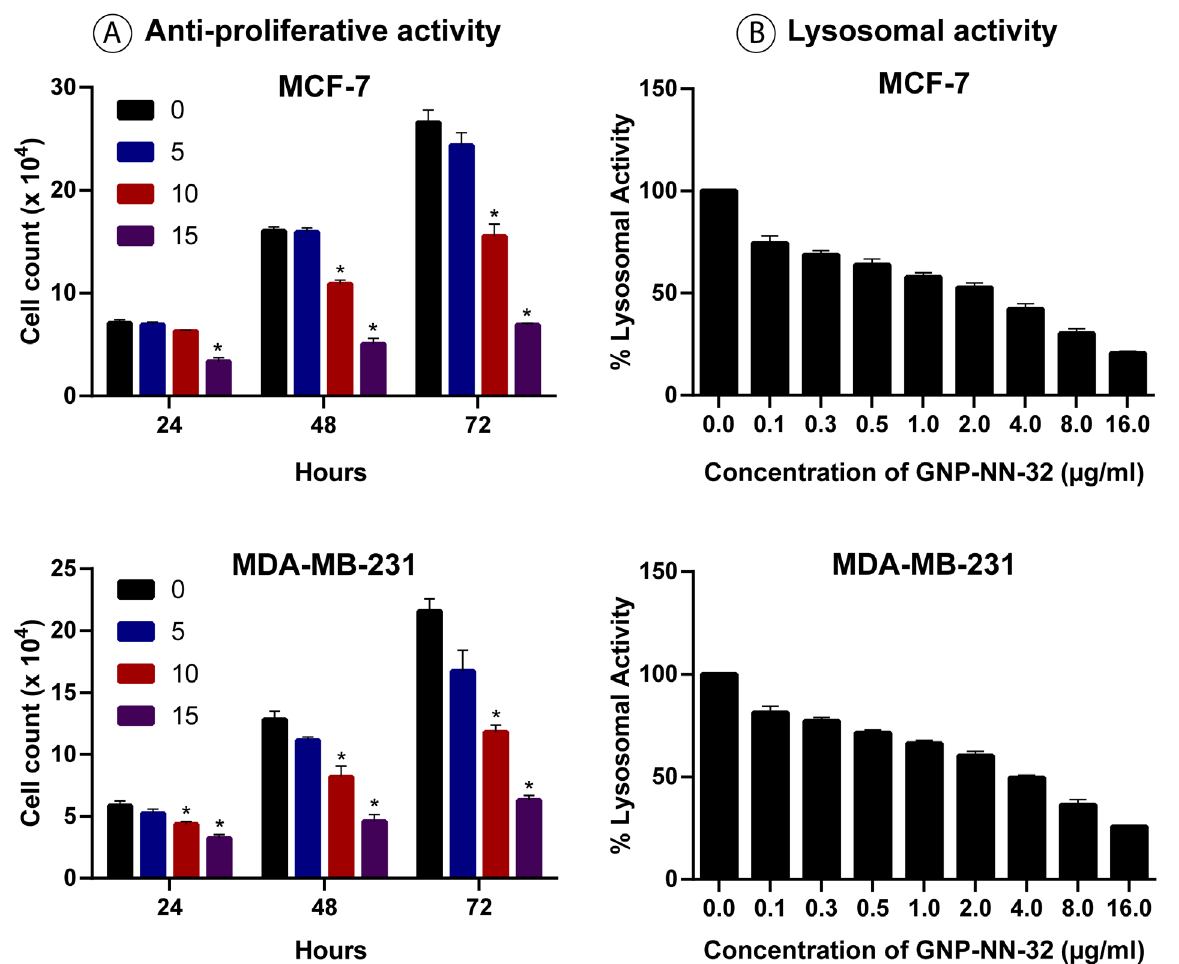
Figure 7. (A) Viability of MCF-7 and MDA-MB-231 cells treated with GNP-NN-32 after 24, 48 and 72 hours. (B) Lysosomal activity of MCF-7 and MDA- MB-231 cells treated with GNP-NN-32 toxin for 72 hours, determined by neutral red uptake assay. Values are expressed as mean ± standard deviation (n = 3). * p < 0.05 in comparison with the control